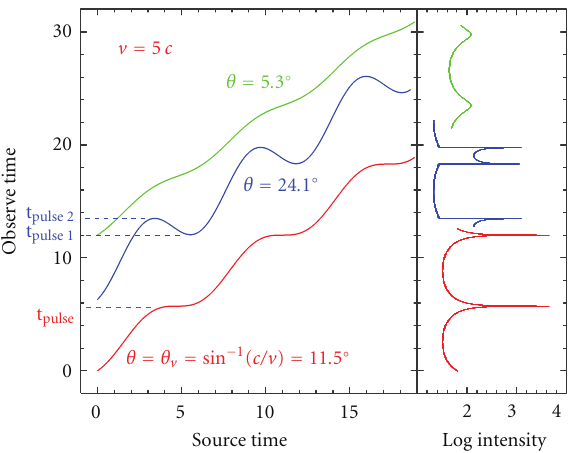
Figure 14: Left: observer time as a function of source time for a supraluminally induced circular excitation at 5 times light speed with a period of 2 π for three polar directions. Delays in the observer time of order millions have been suppressed, and the three curves have been arbitrarily o ff set by a few units for clarity. Right: the integral, into 512 discrete bins per cycle of observer time phase, of source time dwell versus observer time for the three curves (i.e., pulse